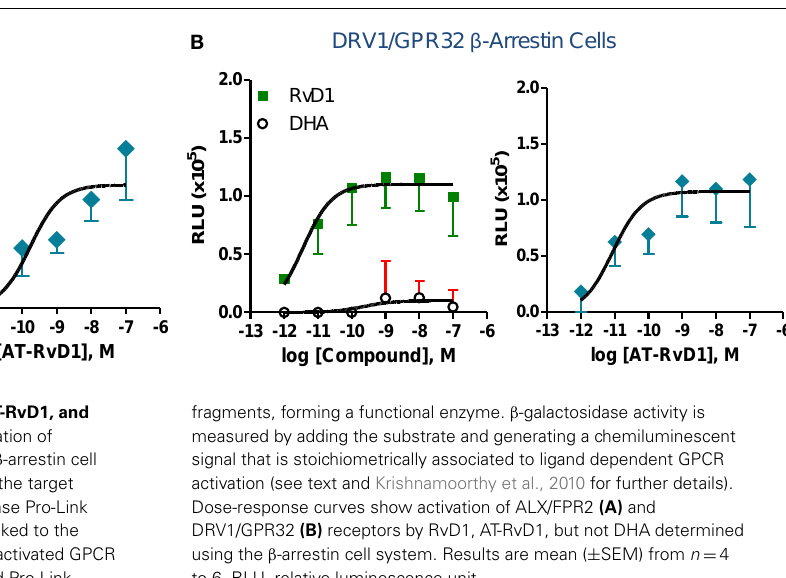
plasmid. Cells were treated with RvD1 andTNF- α (see inset in the right panel). RvD1 reducesTNF- α -stimulated NF- κ B activation in DRV1/GPR32 and ALX/FPR2 receptor-overexpressing cells, while cells transfected with other related GPCRs (e.g., BLT1, BLT2, CB1, GPR-1, FPR, and ChemR23) did not significantly inhibitTNF- α -induced NF- κ B luciferase activity on addition of the ligand RvD1.The results illustrated are expressed in luminescence units subtracted from pNF- κ B and pcDNA3 empty vector (* P < 0.05 vs. BLT2-transfected cells).